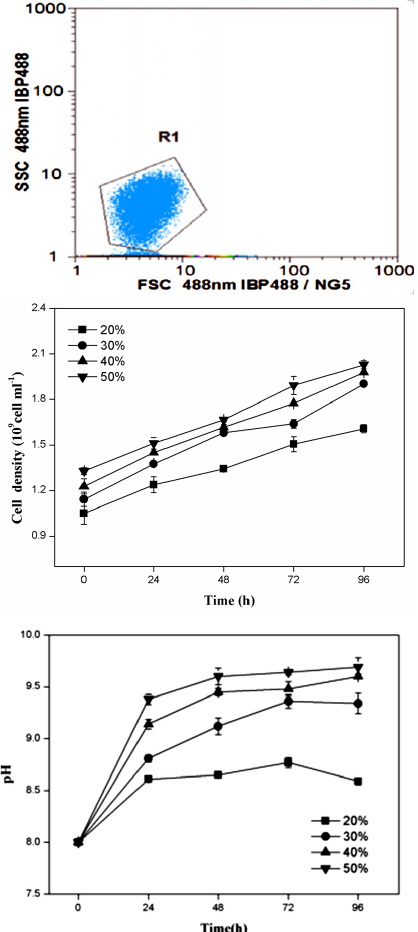
Fig. 3. Effects of the different inoculums on the growth of R. palustris in landfill leachate, the cell scatter diagram of R. palustris (a), the cell densities of R. palustris (b) and the change of pH